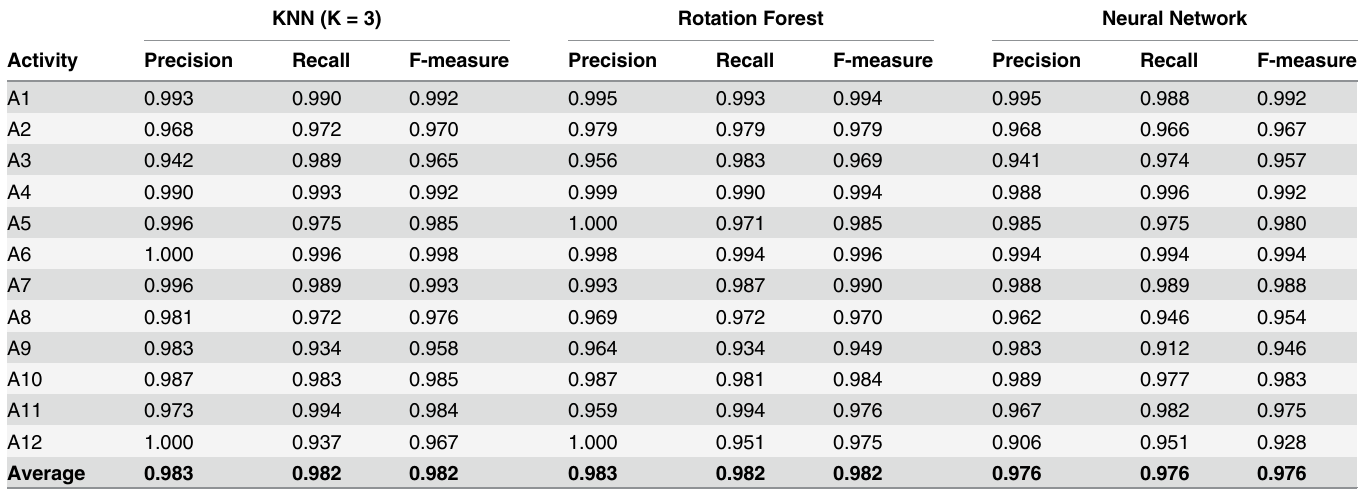
Table 8. Classification results of three classifiers using all acceleration